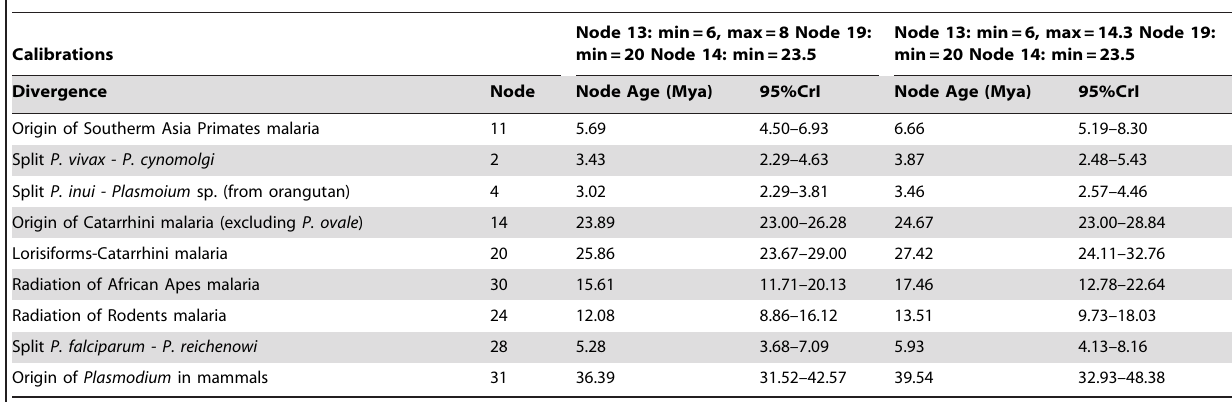
Table 6. Divergence times of major splits in the malarial phylogeny as estimated by BEAST.